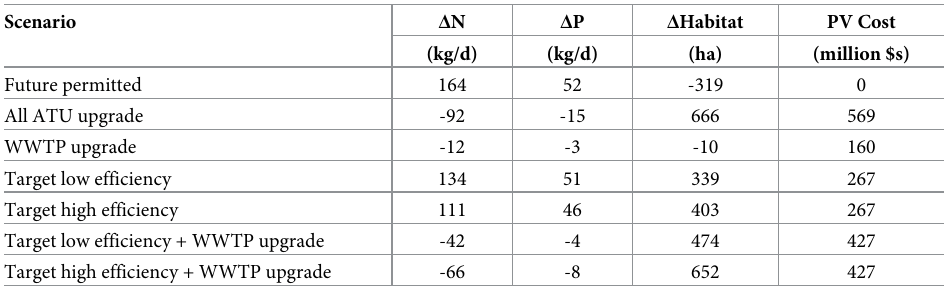
upgrade than they were to the cesspool upgrade efficiency assumptions. In terms of cost- Table 4. Changes in N, P, marine habitat quality, and present value cost relative to the current